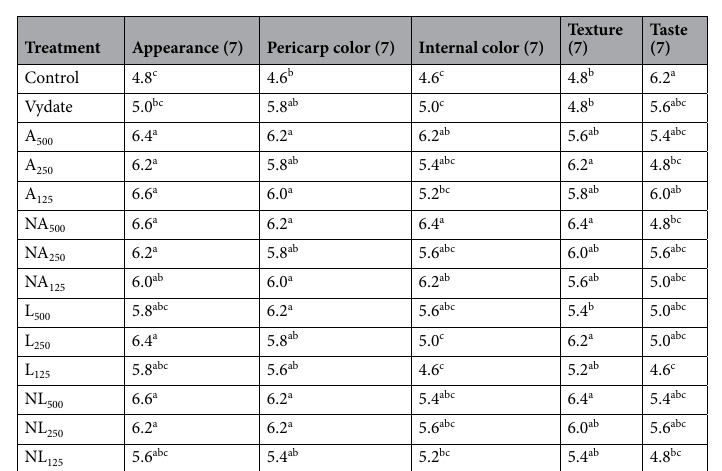
Table 5. Effect of treatments on fruit quality parameters of tomato plants in El-Noubaria, during 2020–2021. Means followed by the same letter(s) are not significantly (P < 0.05) different.